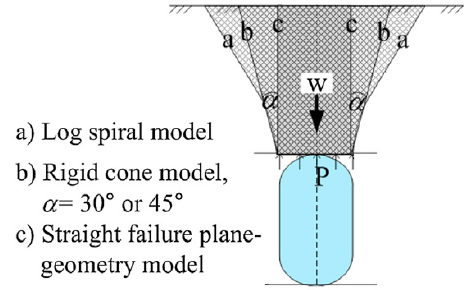
Figure 1. Three models for action of ground against lift-up due to gravity. W is weight, alpha is the angle of friction of the rock mass, usually 30 – 45 degrees [19].